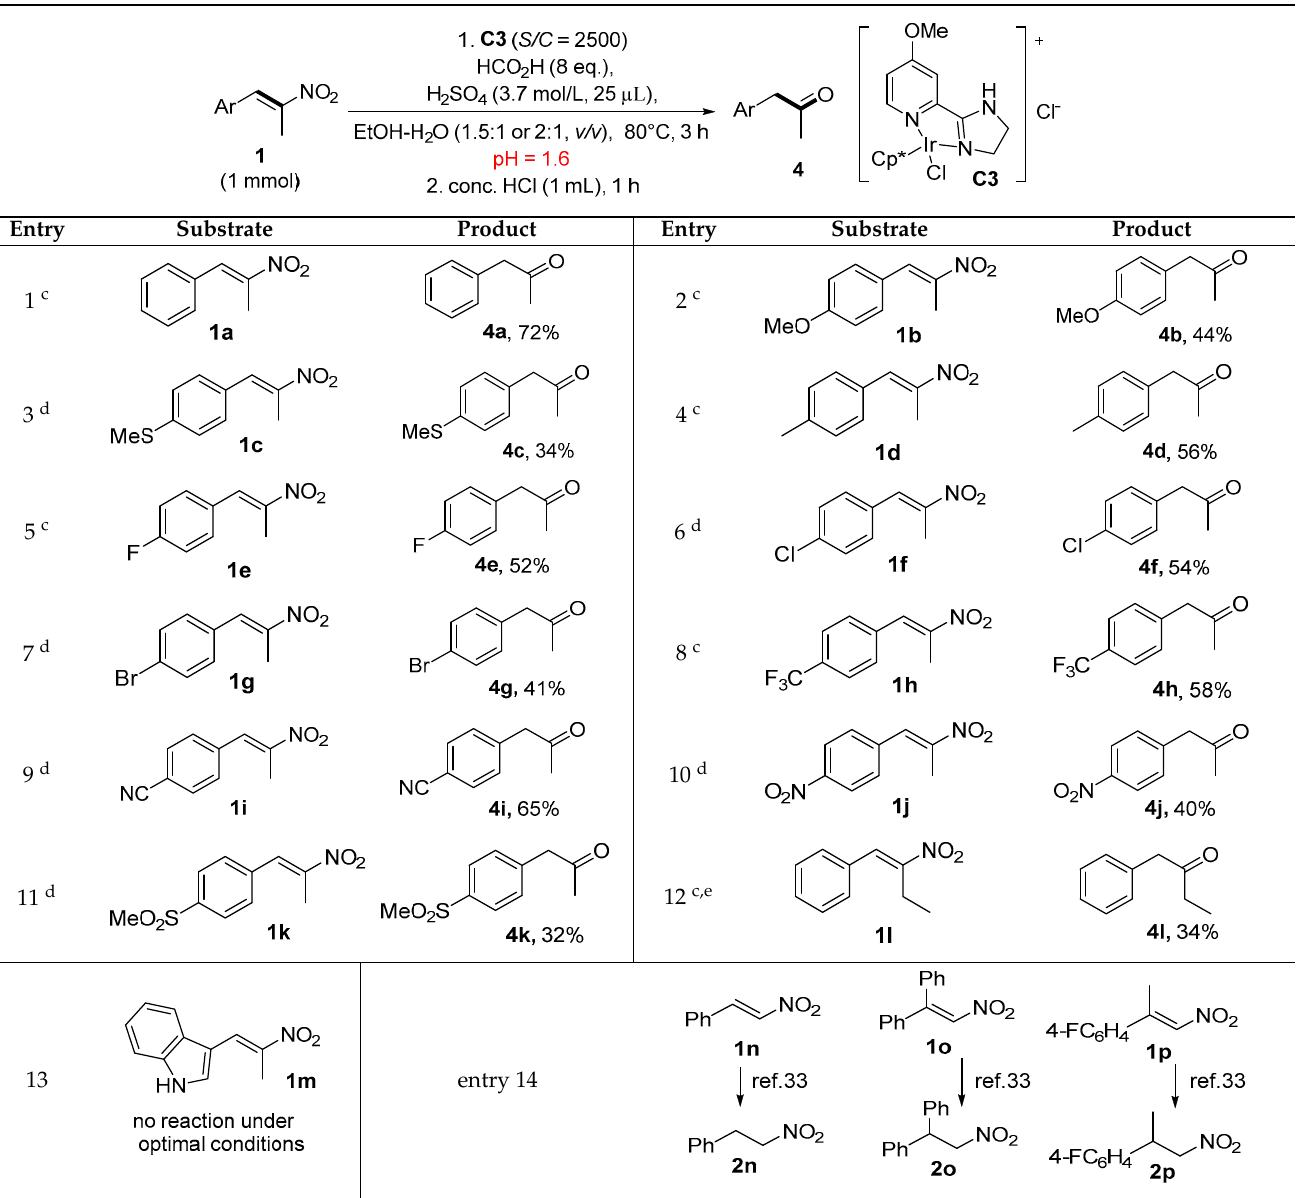
Table 2. Conversion of different nitroalkenes a,b .